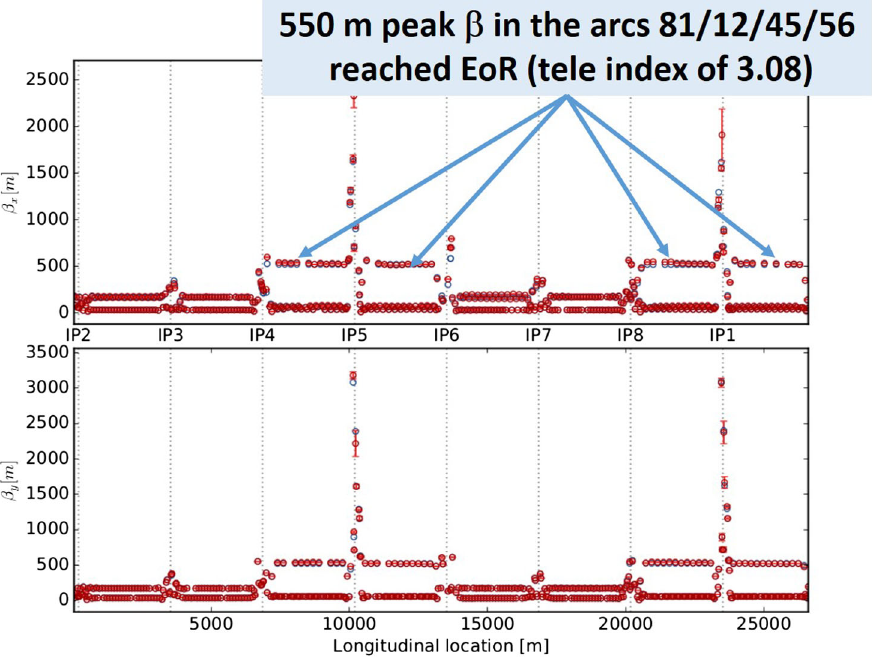
¼ 65 cm), leading to an Tele